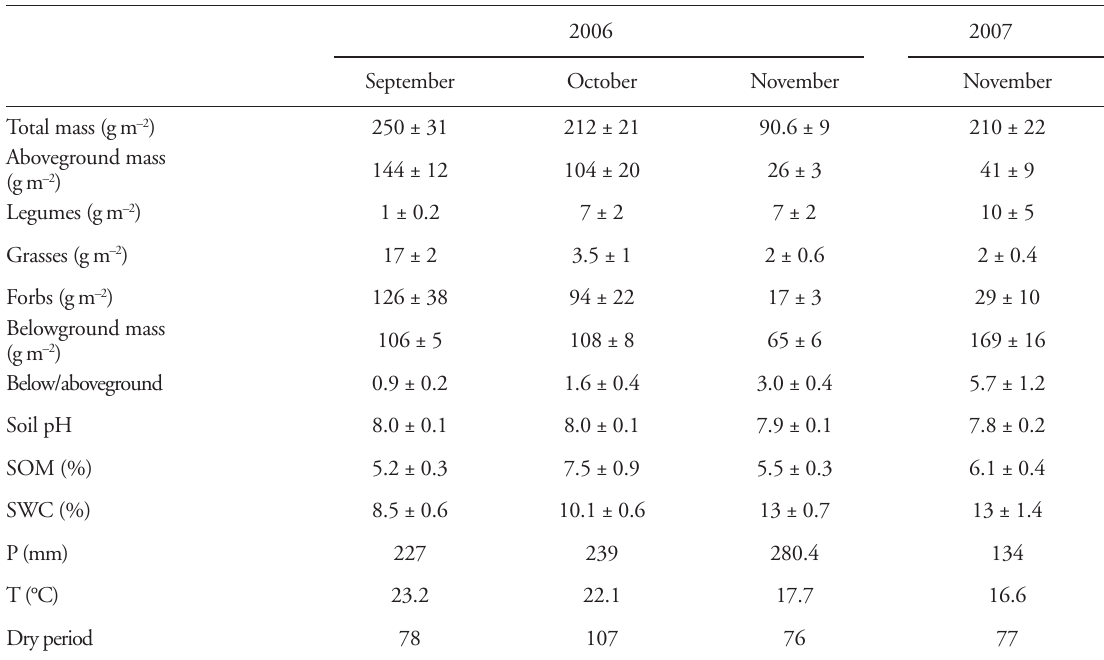
Table 2. Total, aboveground and belowground phytomass (g m –2 ) in gaps of the low Macchia at Castel Volturno nature reserve and main soil parameters measured in September and October 2006 (late summer production), in November 2006 and 2007 (early phase production of the vegetative cycle). Climatic parameters refer to the periods July–September, July–October for late summer produc- tion, and September–November for the early phase production. Values of biomass and soils parameters are means of 18 measurements at each harvest.